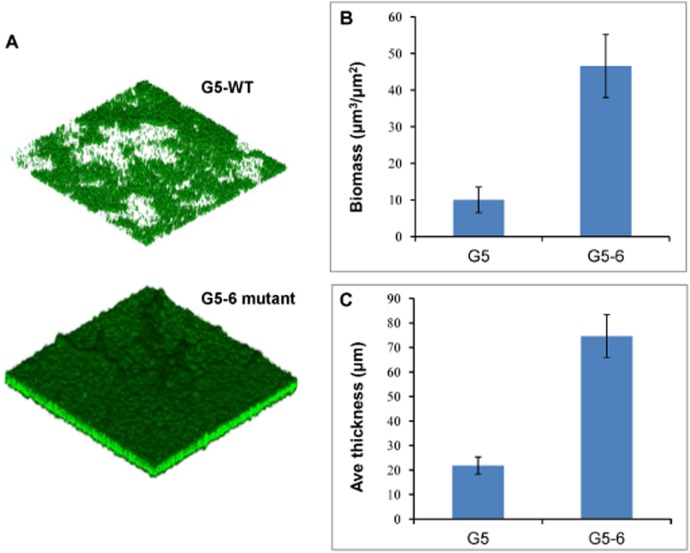

gacA inactivation induced biofilm formation.
A, biofilm formation after 48 hr incubation at 30°C with shaking at 80 rpm was visualized by CLSM. B, biofilm biomass and C, the average thickness were quantified between the wild type G5 and the gacA mutant G5-6 using COMSTAT2 software (p<0.01).